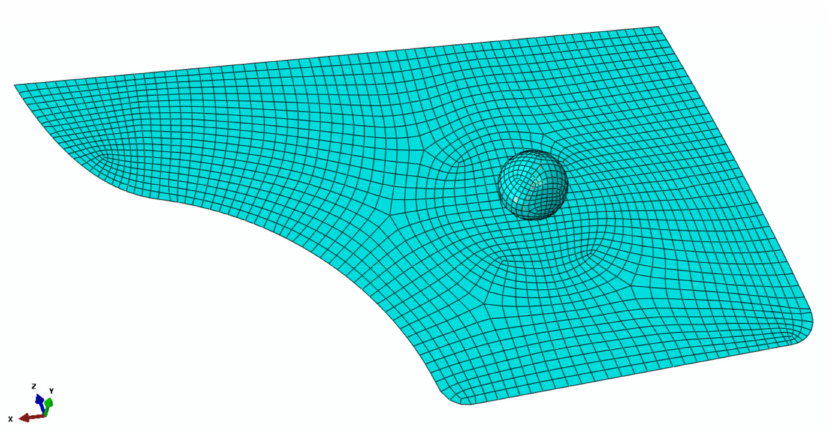
Figure 6. The mesh and dimension of the car door interior.